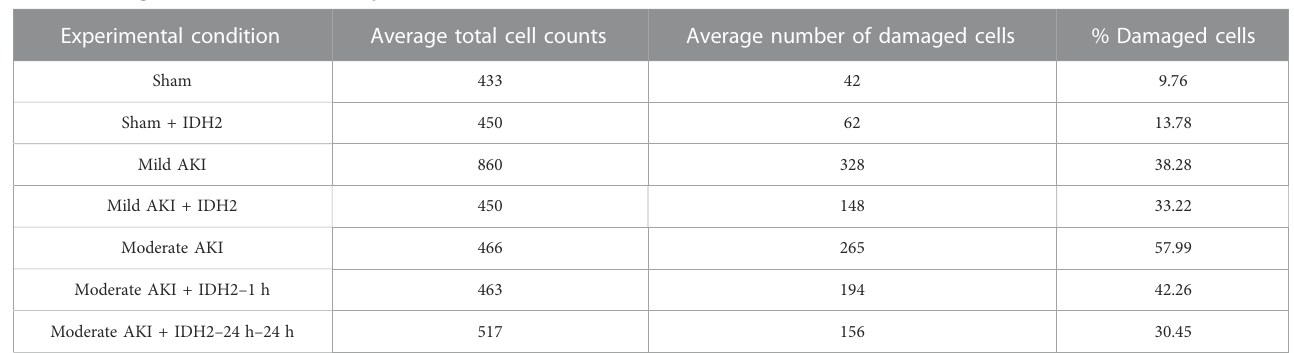
TABLE 1 Histological assessments for each experimental condition. Experimental condition